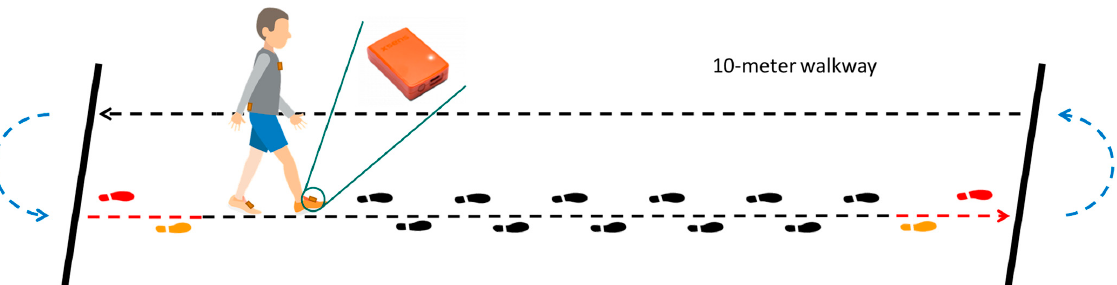
Figure 1. Set-up for 2 min walking test. Participants were instructed to turn after the 10 m marks (thick, black lines), but no specific instructions on how to turn were given (e.g., pivot turn or taking multiple steps). Orange and red indicate the first and second foot strike after a turn (blue) and the last and second to last foot strike before the turn start, respectively.